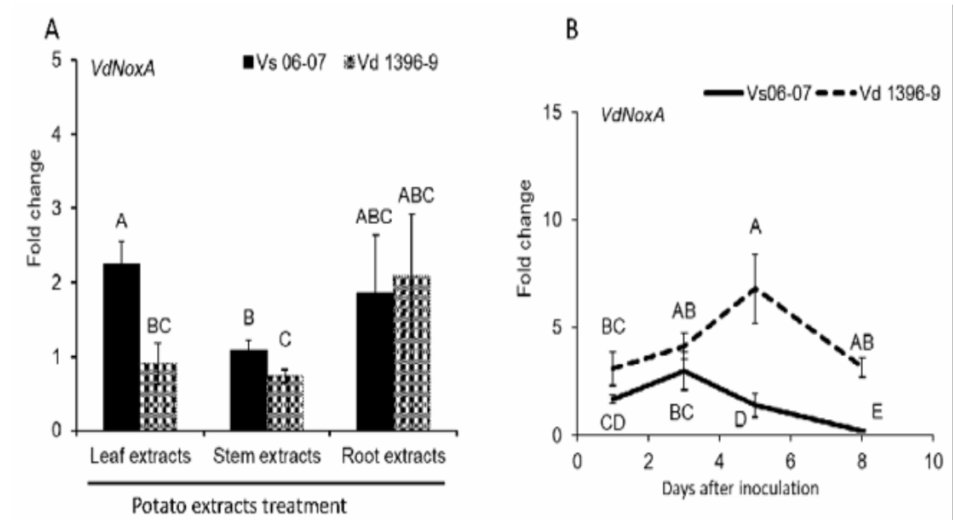
Figure 1. Expression of NoxA gene in V. dahliae under elicitation or during the infection. ( A ) Ex- pression of NoxA , in response to potato leaves, stems, and roots extracts. The highly (Vd1396-9) and weakly (Vs06-07) aggressive isolate were cultured in liquid CDB medium added with potato leaves, stems or roots extracts. Sterilized distilled water was added into culture medium as a con- trol treatment. Both Vd1396-9 and Vs06-07 cultured in the CDB medium with water were used as calibrators. The V. dahliae Histone H3 gene was employed as the internal control for normalizing all qRT-PCR data. The expression data for each gene in selected isolate in response to treatments were analyzed with the 2 − ∆∆ C T method, in relation to water treatment as the control group. The bars shown as mean values ( n = 3) with different letters were significantly different between treatments ( p < 0.05). Error bars refer to standard error. ( B ) Expression of NoxA during the infection on detached Kennebec potato leaves. Four to six pieces of four-week-old Kennebec potato detached leaves from different individual plant were combined as one sample after inoculation by highly (Vd1396-9) or weakly (Vs06-07) aggressive isolate using 10 8 conidia/mL. Sterilized distilled water was mocked to inoculate the detached leaves as the control treatment. Three combining samples were prepared for each treatment at each time point (one, three, five and eight days after inoculation, DAI). Both Vd1396-9 and Vs06-07 cultured in CDB medium were used as the calibrators. The V. dahliae Histone H3 gene was employed as the internal control for normalizing all qRT-PCR data. The expression data for each gene during the infection were analyzed with the 2 − ∆∆ C T method, in relation to isolates cultured in CDB medium as the control group. The point values showed as mean values ( n = 3) with different letters were significantly different between treatments ( p < 0.05). Error bars refer to standard error. The LSD post hoc test was performed to determine which differences are significant among the different treatments. The bars/points with different letters are significantly